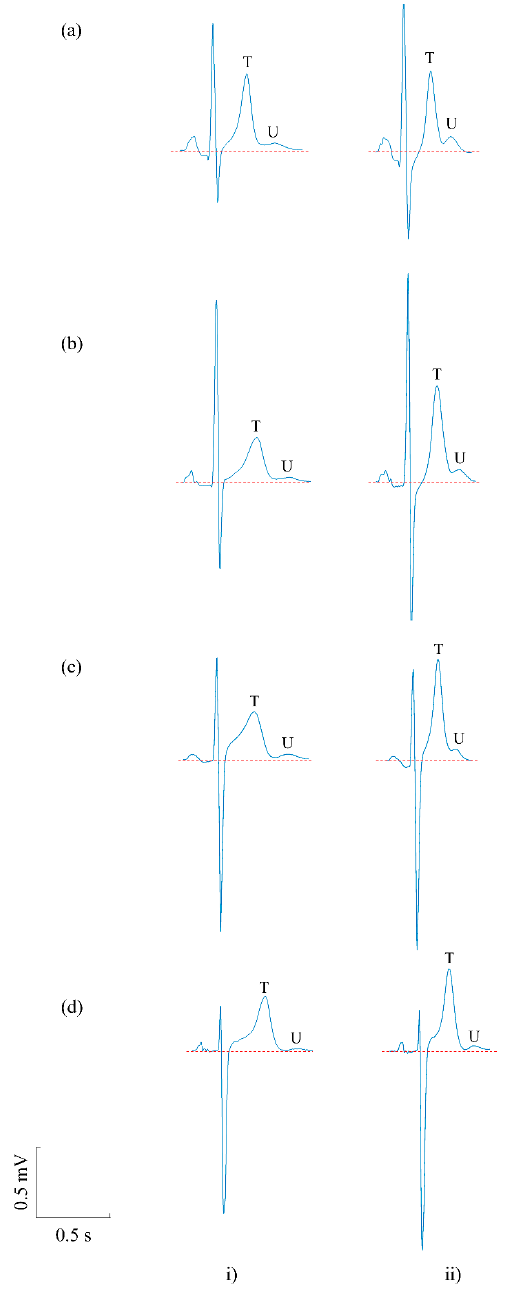
Figure 4. Examples comparing ECG features in ( i ) pre- and ( ii ) post-exercise recordings for four subjects ( a – d ). In both pre- and post-exercise recordings, U waves in the averaged beats were visible and measurable; however, U wave amplitudes were higher in the post-exercise condition in the four subjects. T wave amplitude also increased in these subjects.